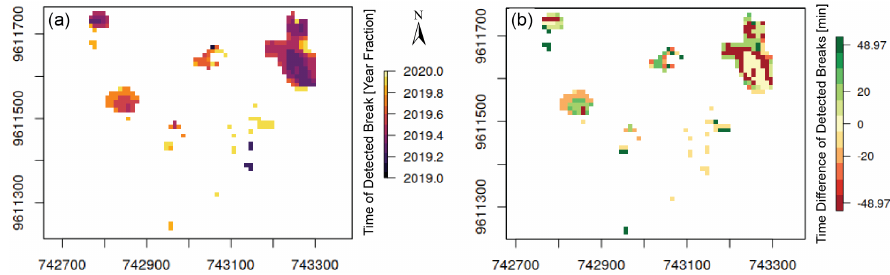
Figure 6. ( a ) The output of the openEO-BFAST workflow calculated at the EURAC backend. The values show the time of detected breaks in Sentinel-1 time series in decimal years. ( b ) The difference between the outputs calculated at the EURAC backend and in a local R environment. The values show the time difference between the detected